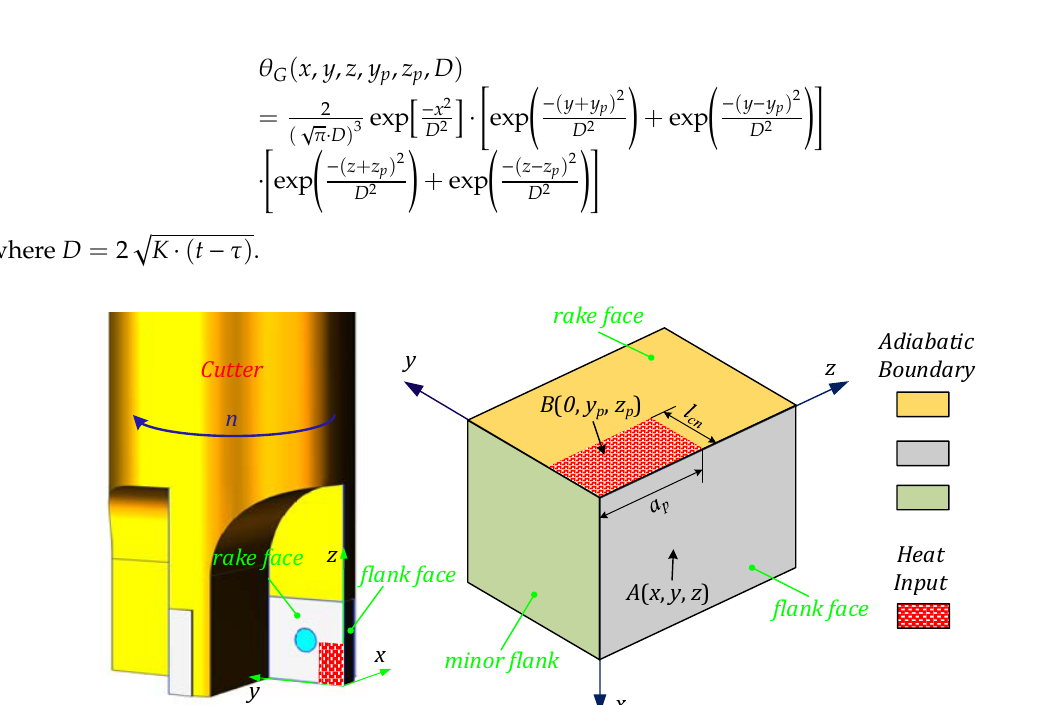
Figure 5. An illustration of the heat transfer problems in cutting process.